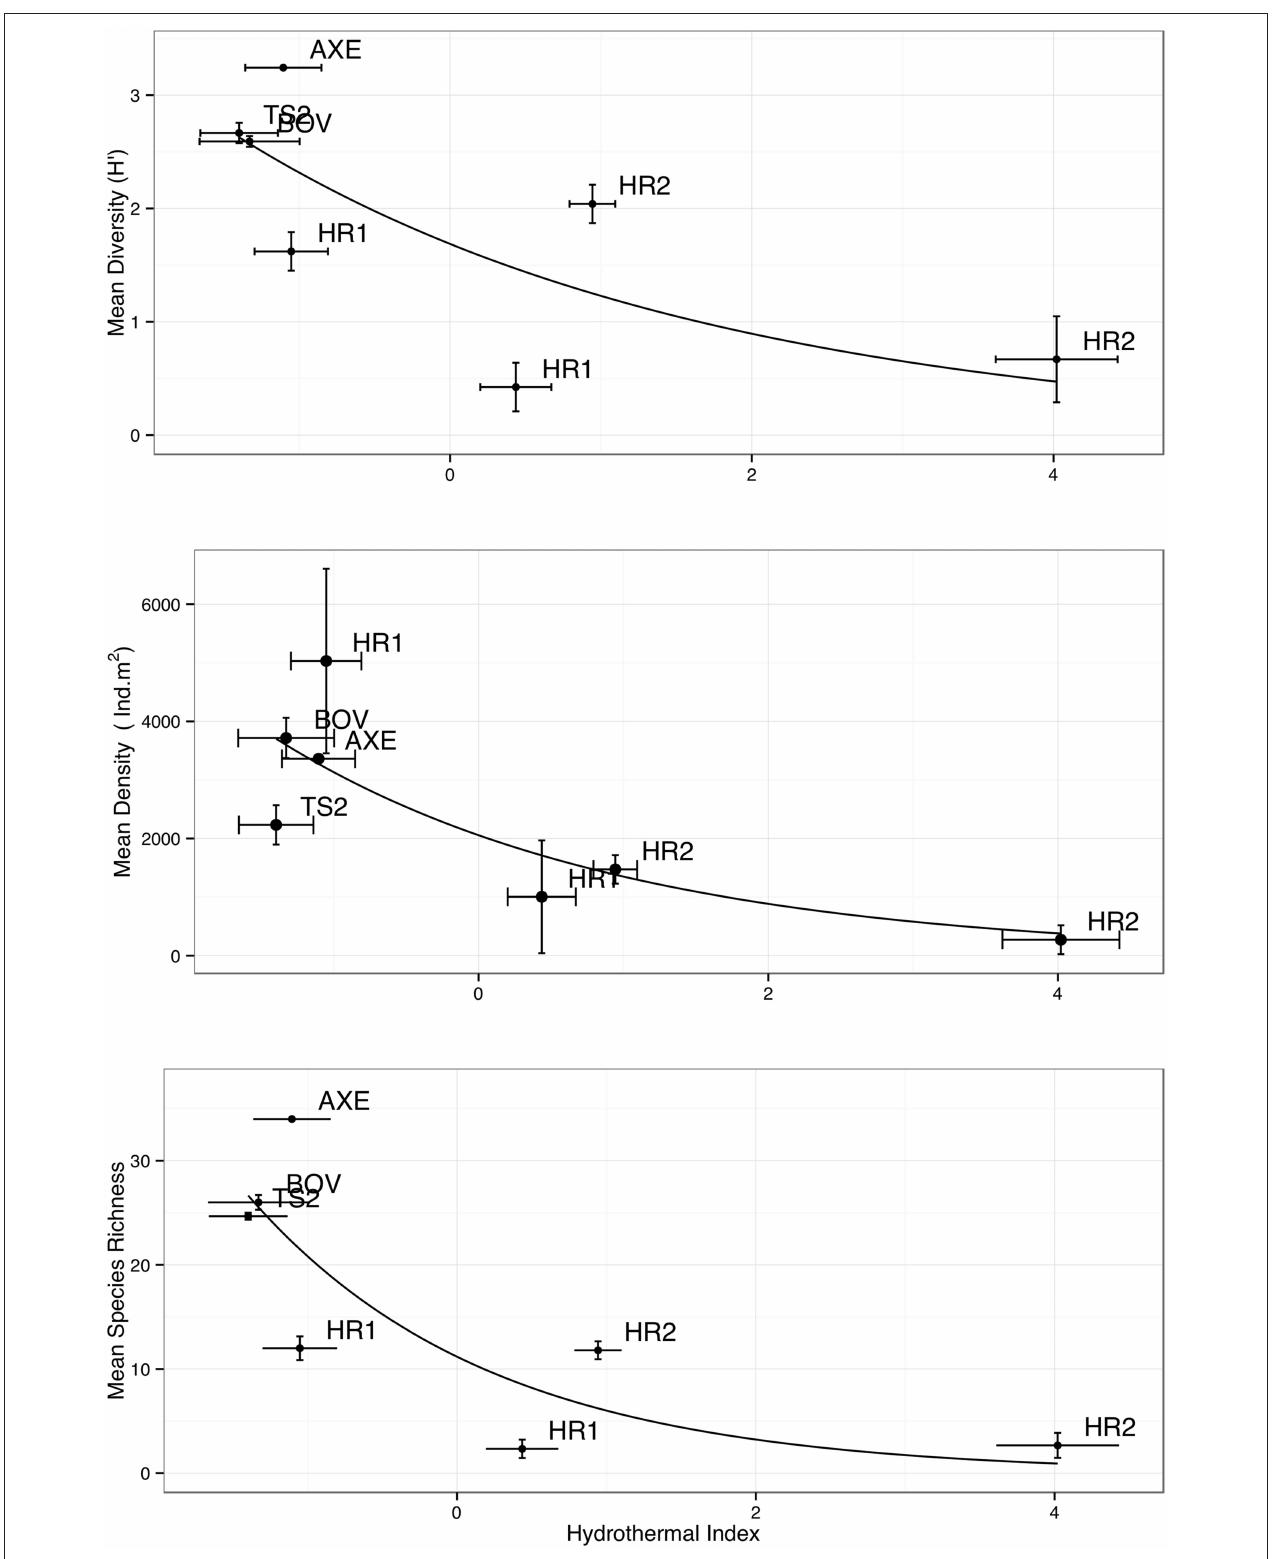
FIGURE 4 | Comparison of “hydrothermal index” with mean diversity, abundance (m 2 ), and species richness (using data from partitioned cores). Higher HI indicates greater levels of hydrothermal activity. Error bars denote ± 1 S.E.